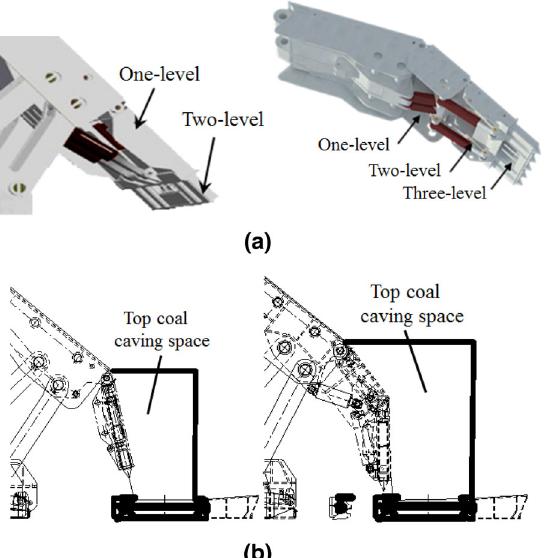
Fig. 7 Two types of top coal caving. a Top coal caving device contrast, b Top coal caving space contrast